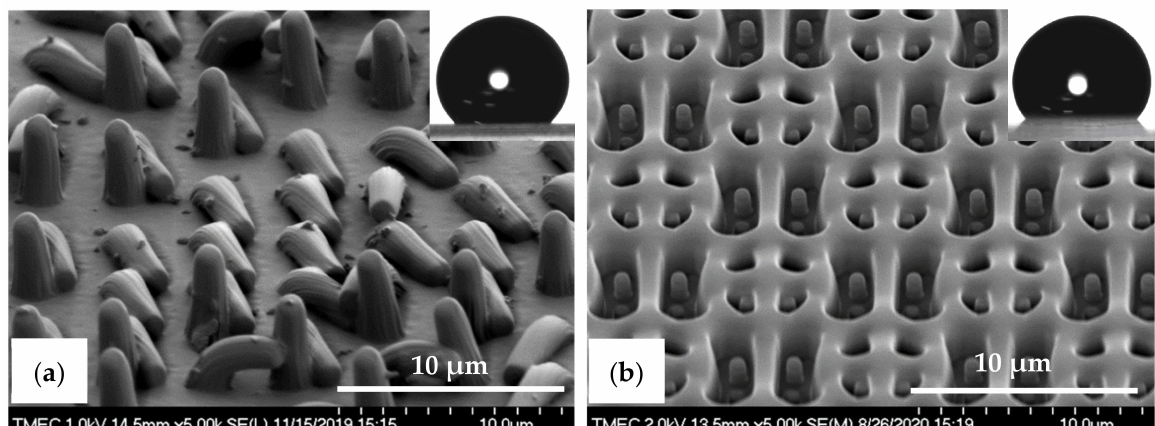
Figure 9. Tilted-view SEM images of the PDMS micro-structures fabricated by soft lithography process after scratch test. ( a ) PDMS-PIL pattern (designed pattern size: diameter: 2.0 µ m, height: 2.5 µ m) and ( b ) PDMS-C-RESS pattern (designed pattern size: diameter: 1.0 µ m, height: 2.5 µ m). The insets show water droplet contact angle images on those PDMS